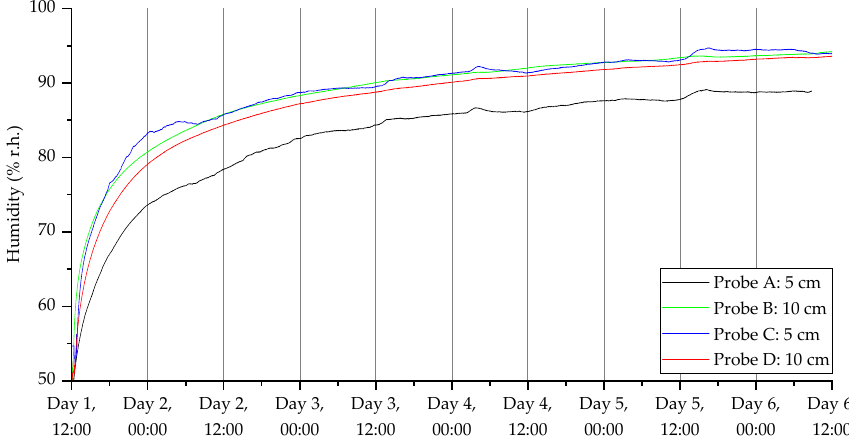
Figure 10. Humidity measurements for the deployment in Warwick campus woodland. Data collection commenced on 11 November 2021 at 12:40 (24 h time).